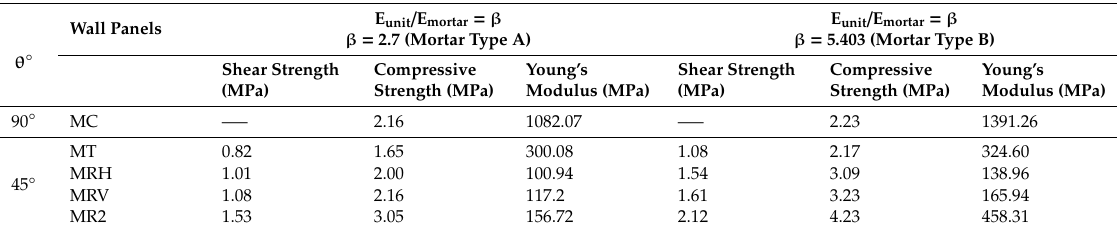
Table 5. Mechanical properties of masonry